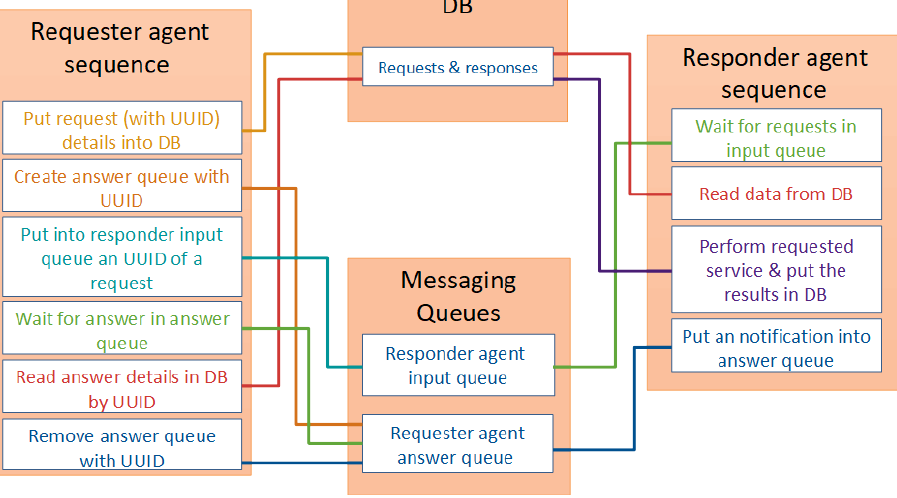
Fig. 1. The Distributed Operating Management System structure.